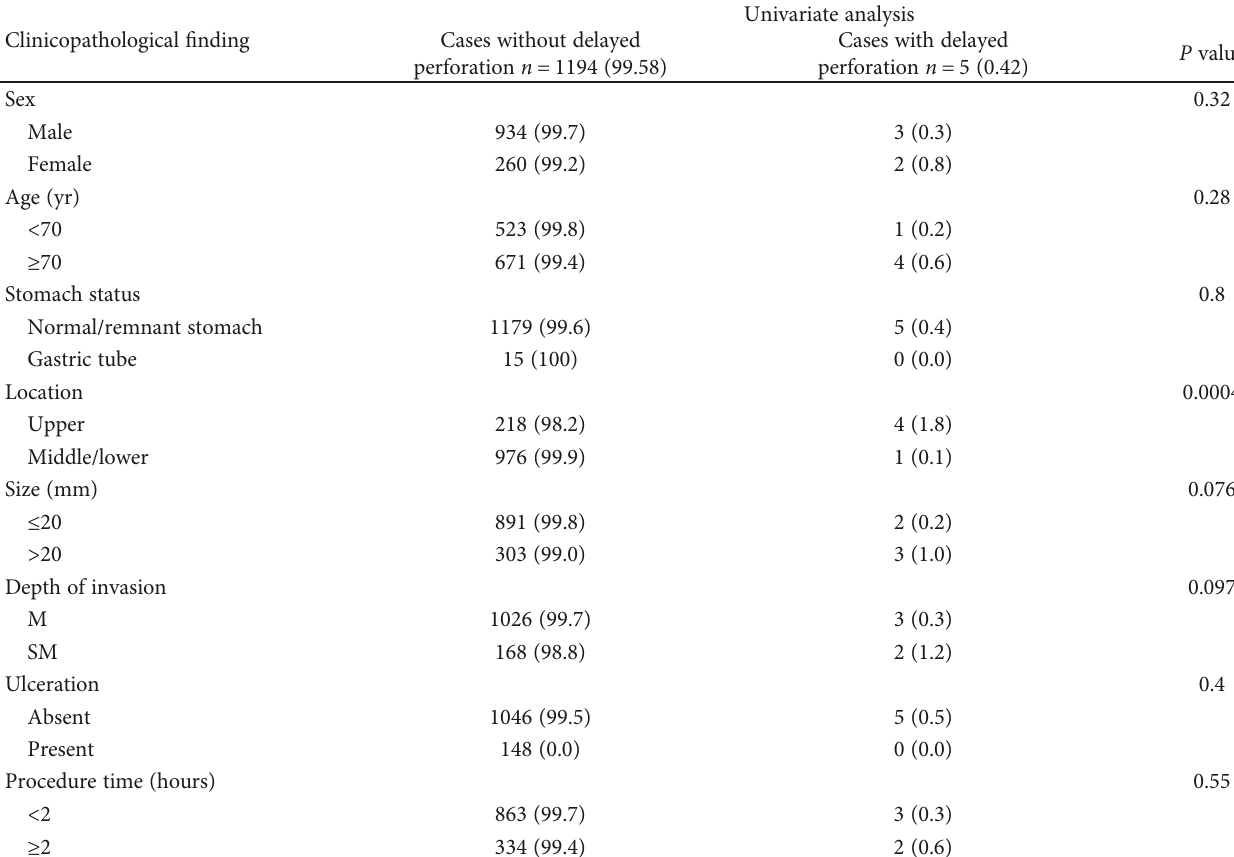
Table 3: Clinical factors related to delayed perforation after gastric endoscopic submucosal dissection (ESD) n